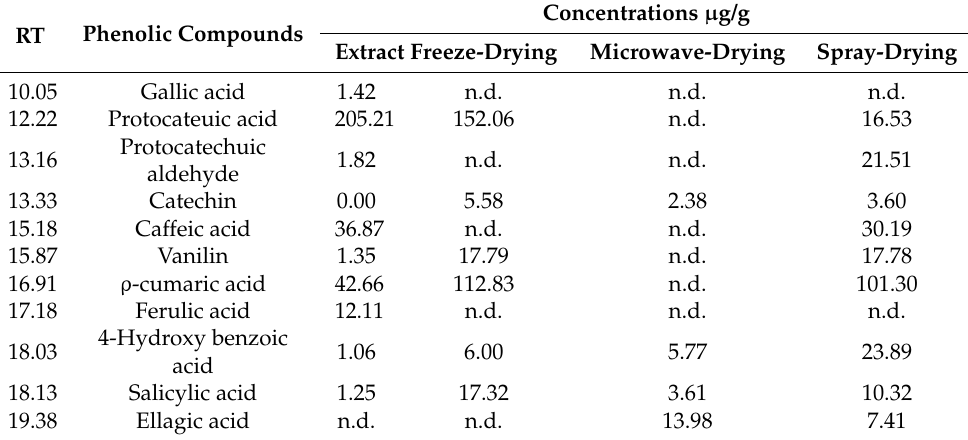
Table 4. LC/MS/MS quantification of phenolic compounds identified in extract and powders. Concentrations µ g/g RT Phenolic Compounds Extract Freeze-Drying Microwave-Drying